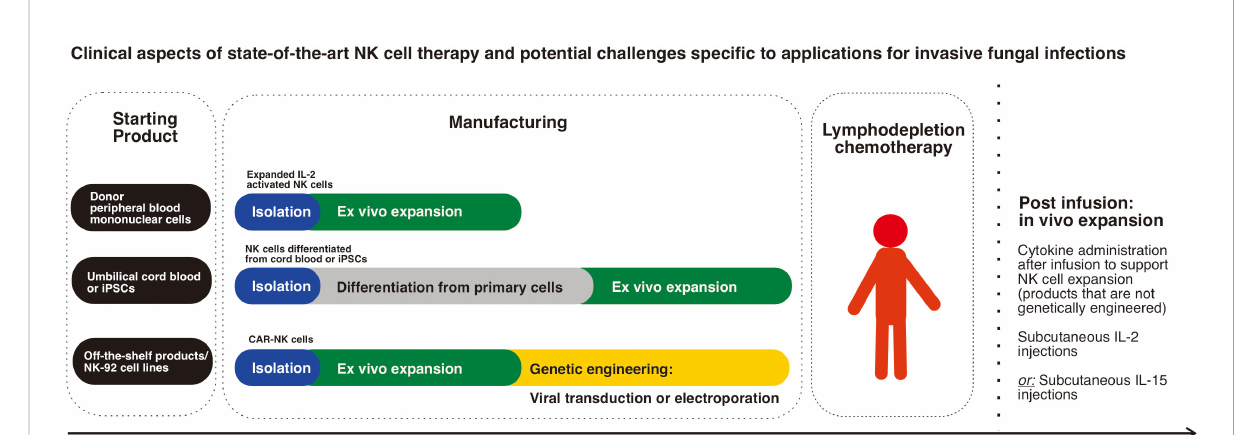
FIGURE 1 Clinical aspects of state-of-the-art NK cell therapy and potential challenges speci fi c to applications for invasive fungal infections: The main sources of NK cells in clinical trials are donor peripheral blood mononuclear cells which are the most commonly used, while next generation genetically modi fi ed products using stem cells (umbilical cord blood cells or iPSCs) are progressively emerging. Schematic diagram representing the main steps in cell manufacturing highlights the complexity and time needed to produce stem cell differentiated products in addition to the need for genetic engineering of CAR-NK cells. The need for lymphodepletion chemotherapy and post infusion cytokine administration, which is the case for most non-genetically engineered products is an important clinical aspect of NK cell